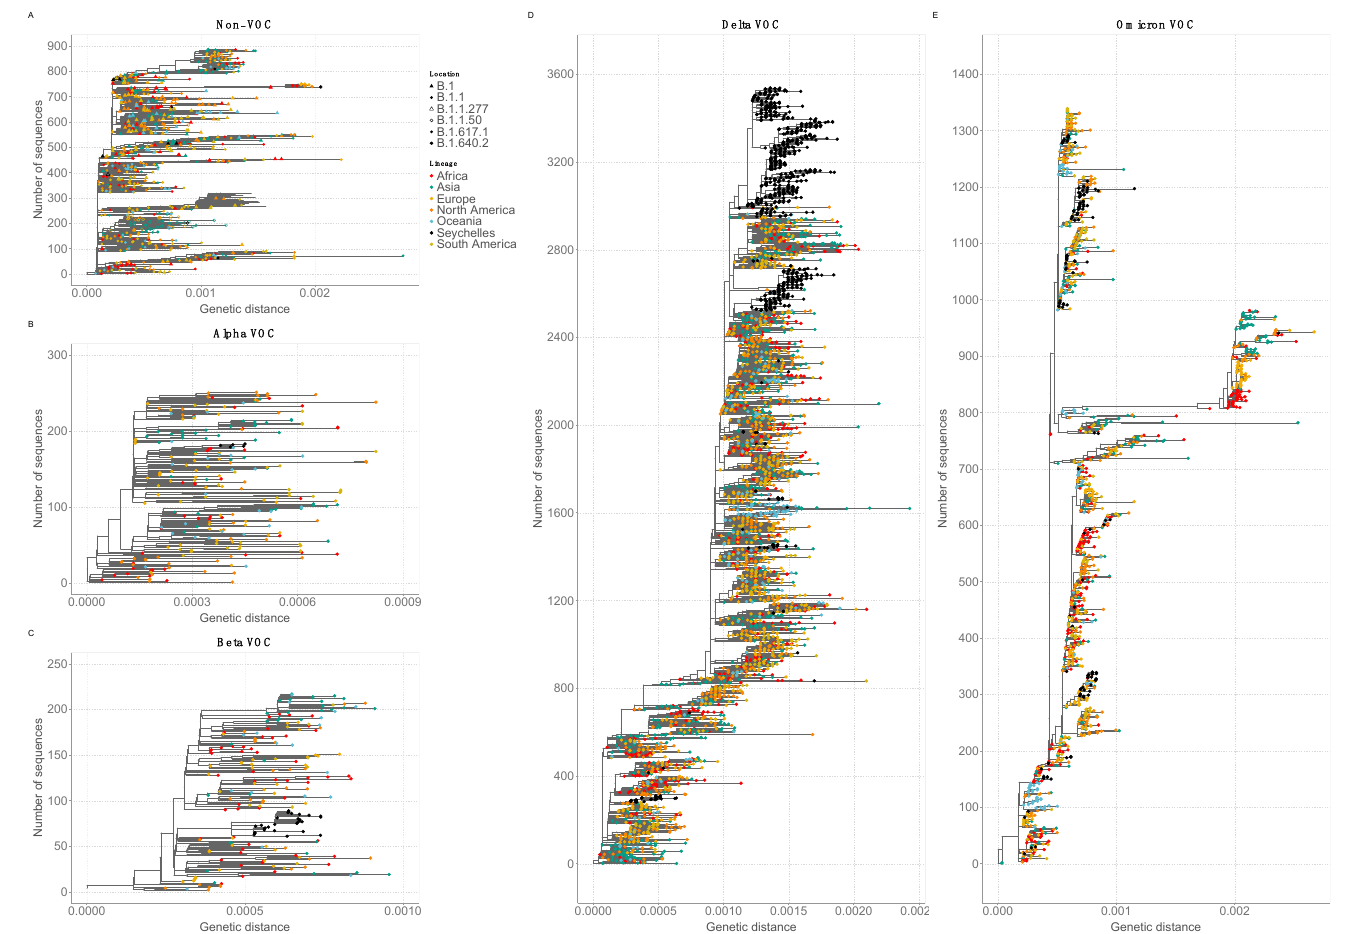
Figure 3. Genetic distance-resolved lineage-specific phylogenetic trees for Omicron, Alpha, Beta, Delta VOC, and Non-VOC. Seychelles genomes are indicated with colored tip labels. ( A ) Phylogeny of Non-VOC that combined 14 Seychelles sequences and 875 global sequences. ( B ) Phylogeny of Alpha VOC that combined 5 Seychelles sequences and 246 global sequences. ( C ) Phylogeny of Beta VOC that combined 29 Seychelles sequences and 187 global sequences. ( D ) Phylogeny of Delta VOC that combined 863 Seychelles sequences and 2676 global sequences. ( E ) Phylogeny of Omicron VOC that combined 145 Seychelles sequences and 1195 global sequences.